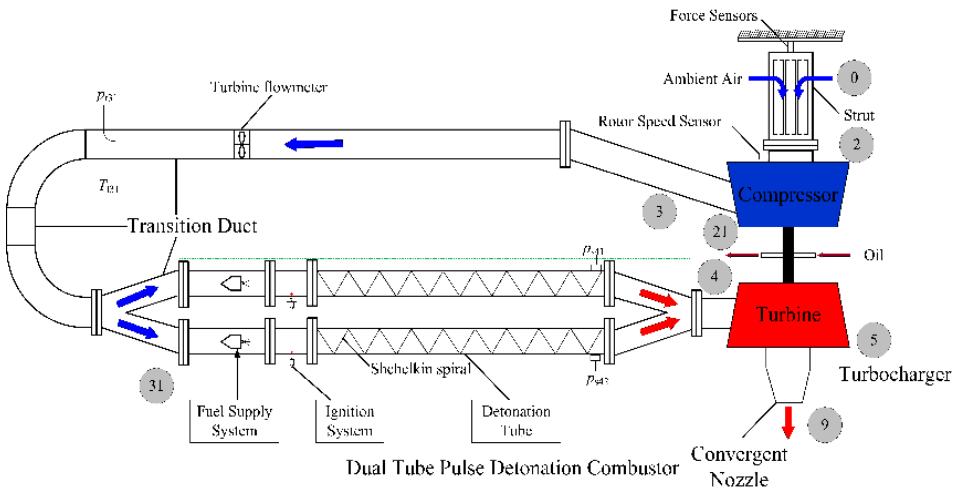
Figure 3. Schematic diagram of the PDTE prototype engine.